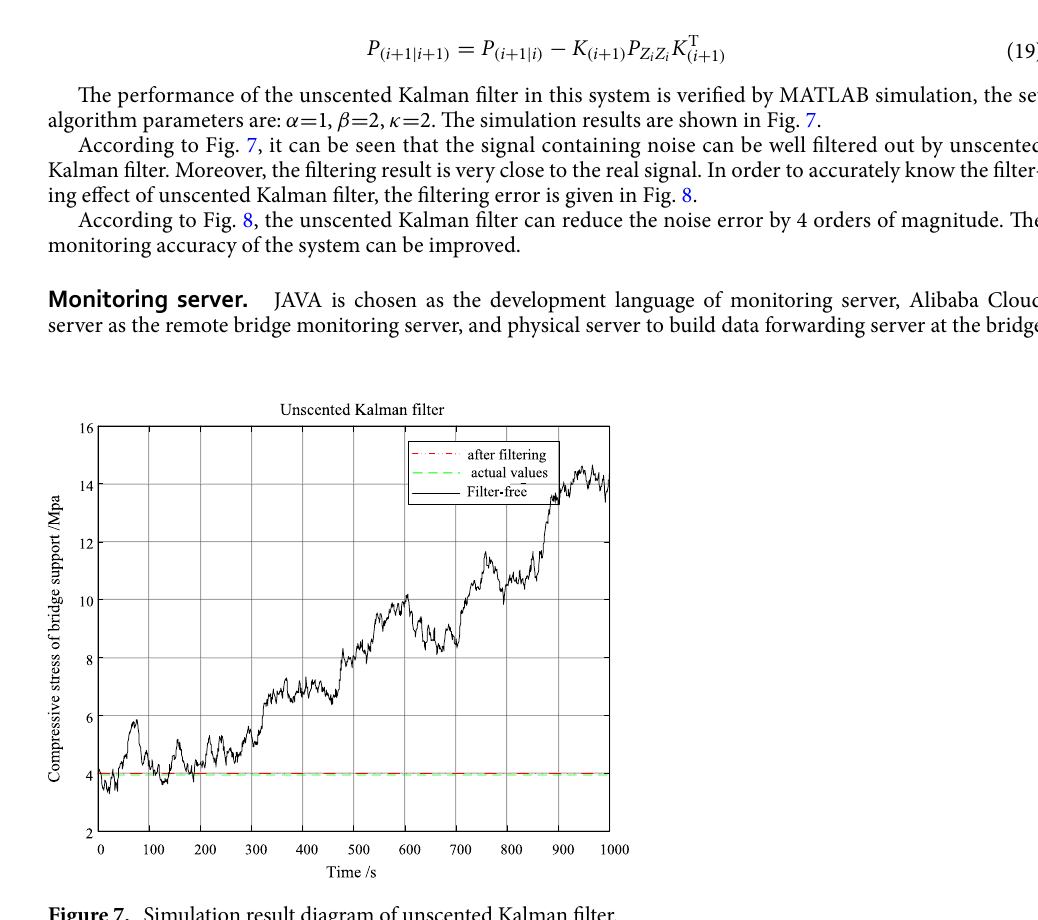
Figure 7. Simulation result diagram of unscented Kalman